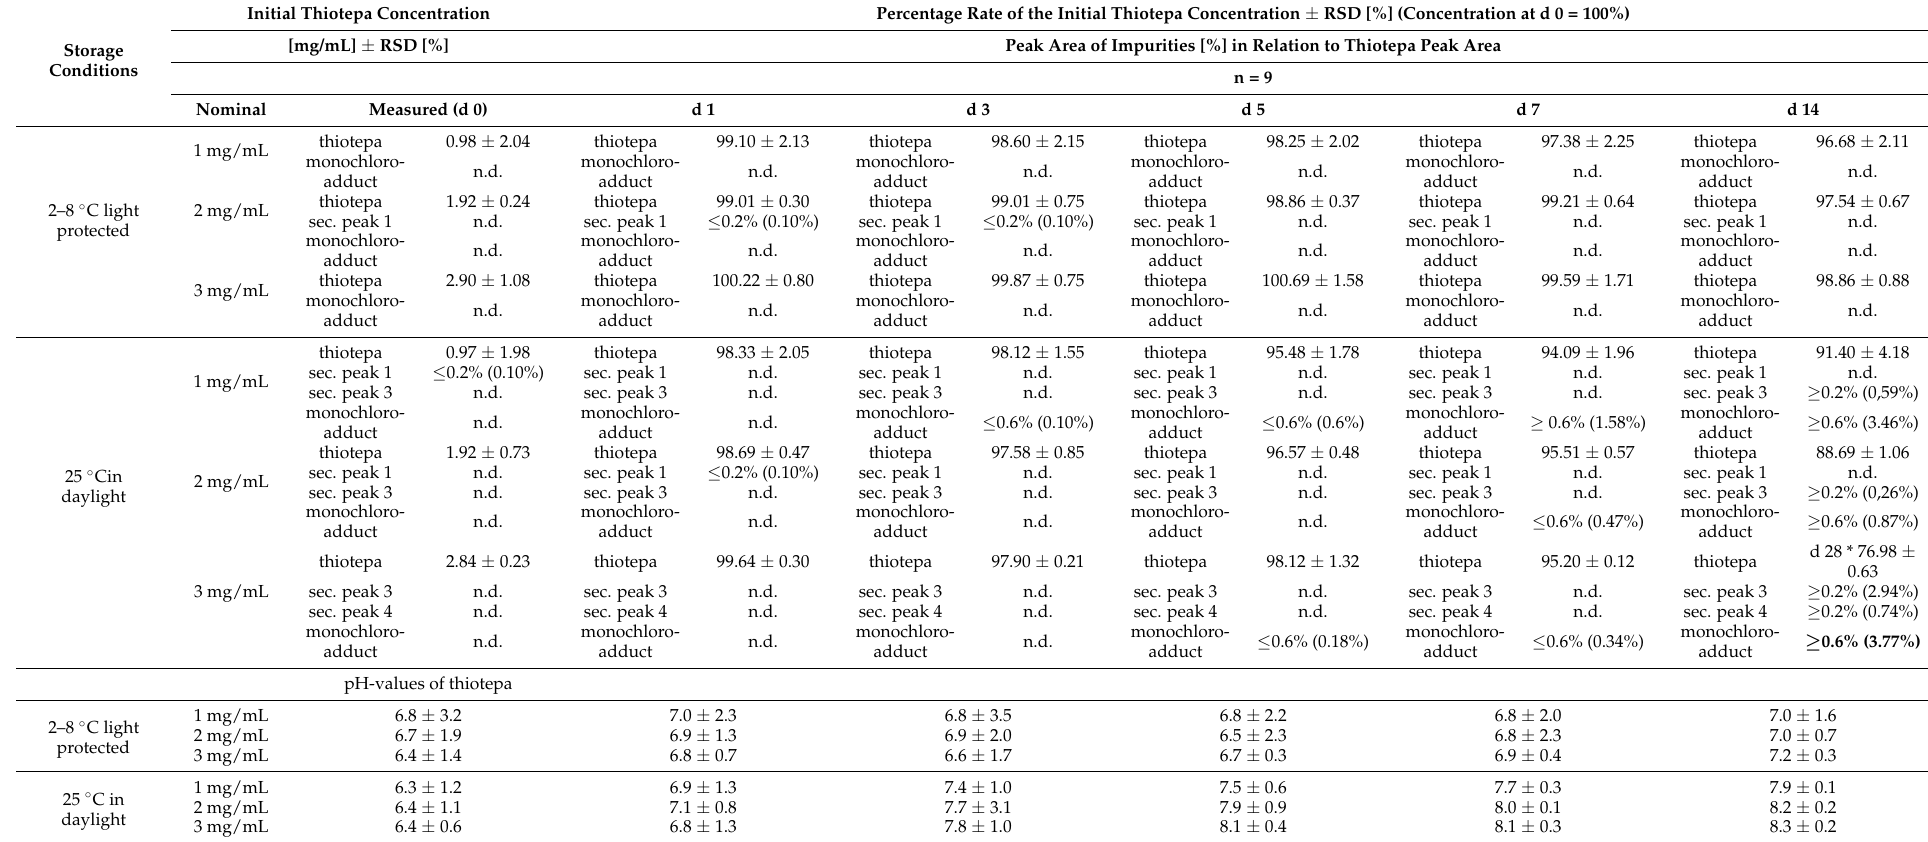
Table 4. Thiotepa concentration, peak areas of secondary peaks and pH of thiotepa infusion solutions (1 mg/mL, 2 mg/mL, 3 mg/mL) diluted in 0.9% NaCl carrier solution stored under two different conditions for 14